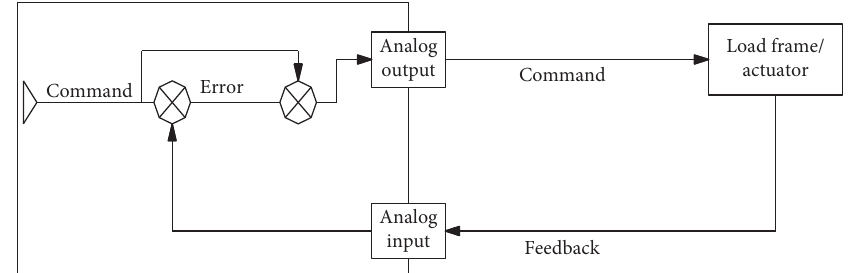
Figure 4: MTS815.03 servo control